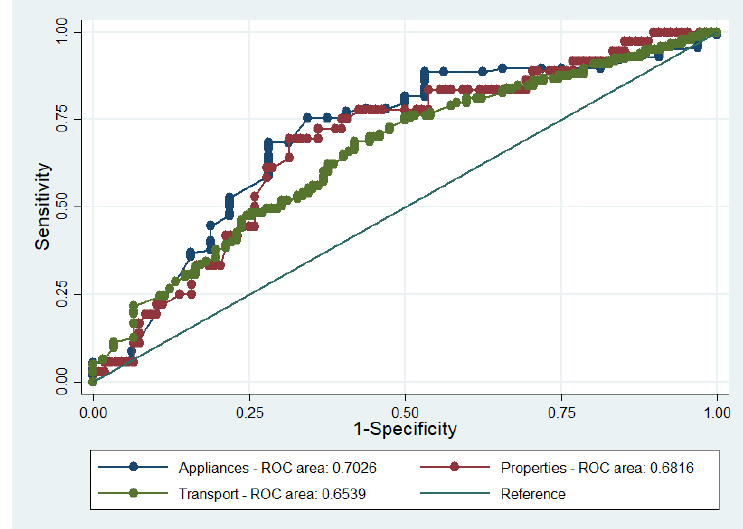
Figure 6. ROC curves and C-statistic estimates for the technological models (firms).